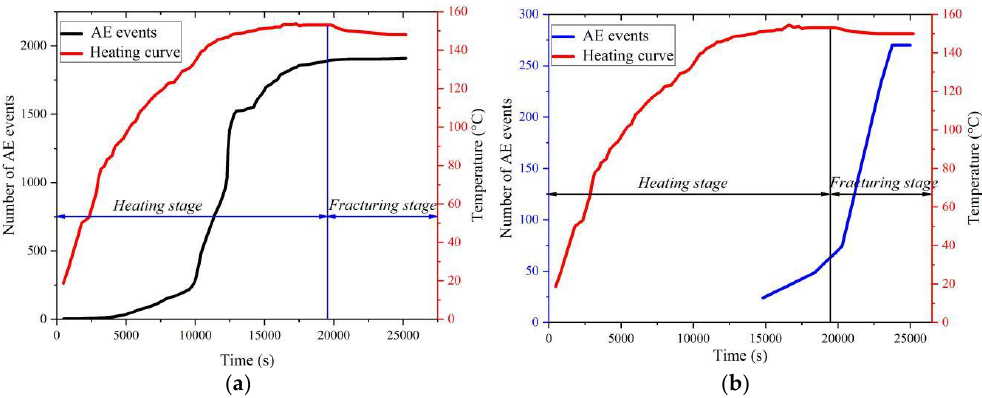
Figure 13. Number of AE events over time during the heating and fracturing test of the Monzogranite specimens. ( a ) MG-7 sample at a threshold amplitude 30 dB and ( b ) MG-8 sample at a threshold amplitude of 60 dB.